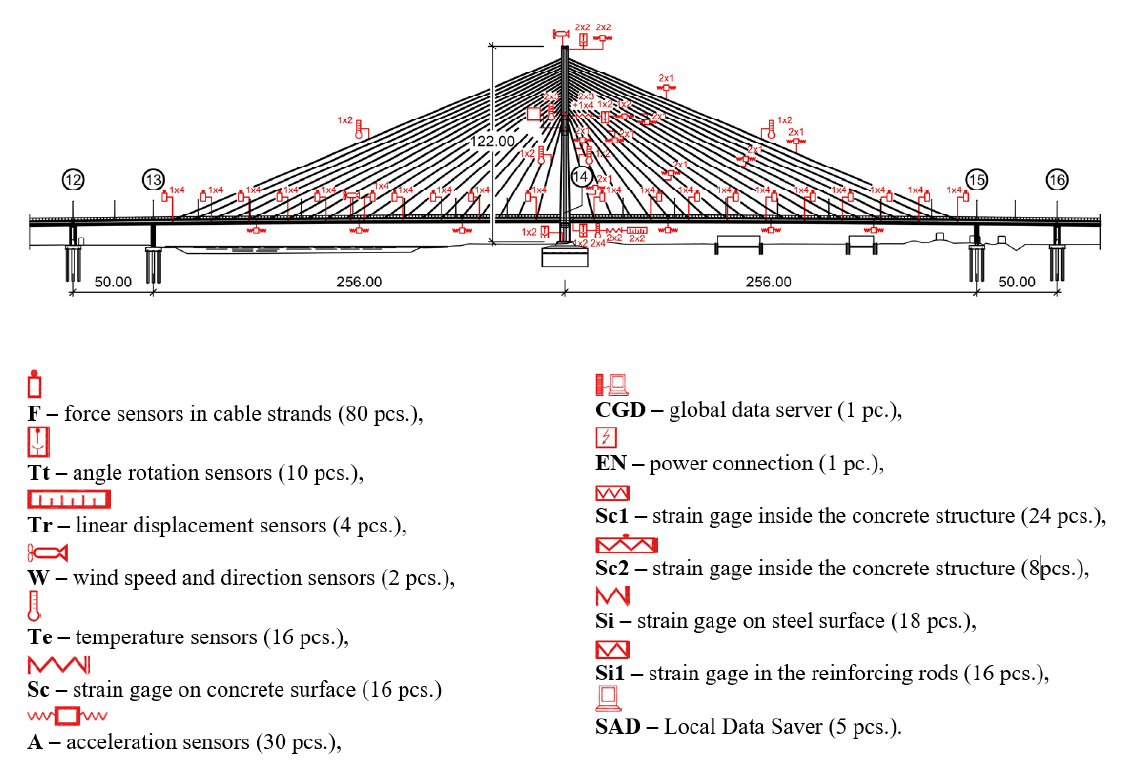
Figure 3. The structural health monitoring (SHM) system scheme [6]. Table 2. Examples of sensor